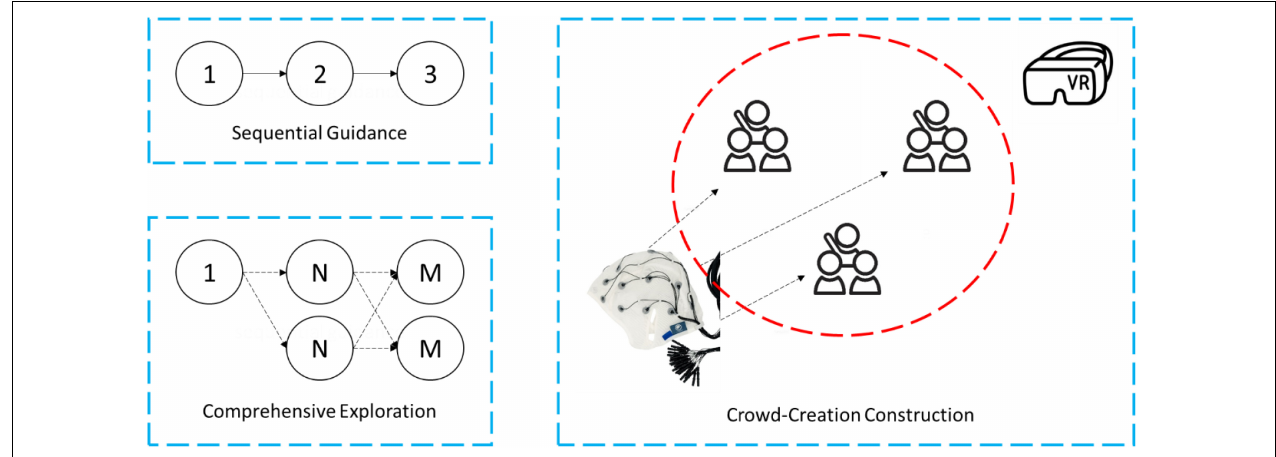
FIGURE 2 | The architecture of experiential English-teaching